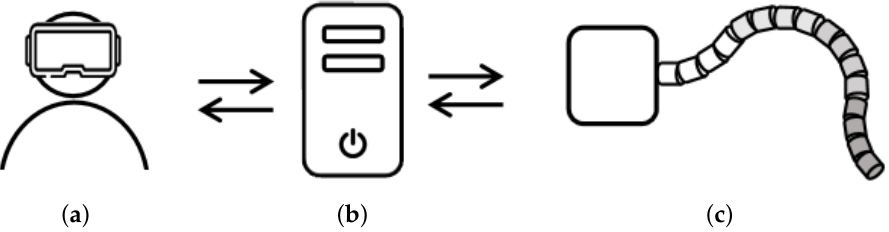
Figure 1. Scheme for teleoperation. ( a ) Operator and the MR interactive device. ( b ) PC-side control platform. ( c ) Flexible manipulator with an RGB-D